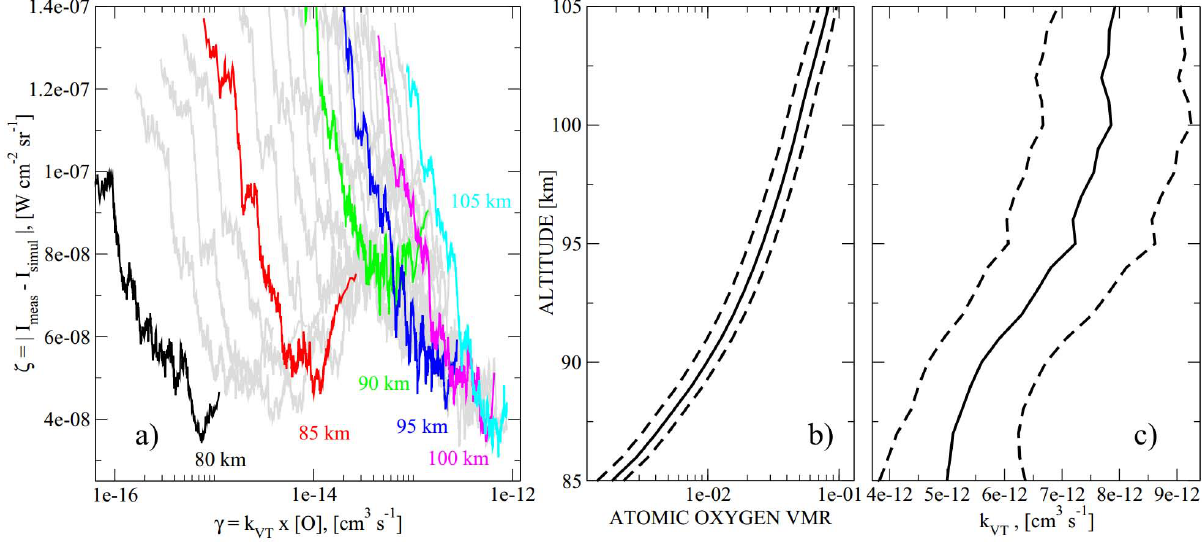
Fig. 2. Estimating the optimal k VT from the overlapping SABER and lidar measurements: (a) deviations between calculated and measured I 15 µ m at different altitudes with respect to a combined γ value (see text). Each ζ(γ,z ) curve in this panel represents the average over 72 individual deviations. Note the existence of ζ(γ,z ) minima at all heights up to 105km (cyan curve); (b) solid line: average O (z) built for all overlapping events, dashed lines: standard deviations for O (z) estimated in Mlynczak et al. (2012); (c) solid line: k VT (z) obtained as a result of dividing the individual minima found in the left panel by atomic O VMRs from the middle panel; dashed lines: standard deviations for k VT